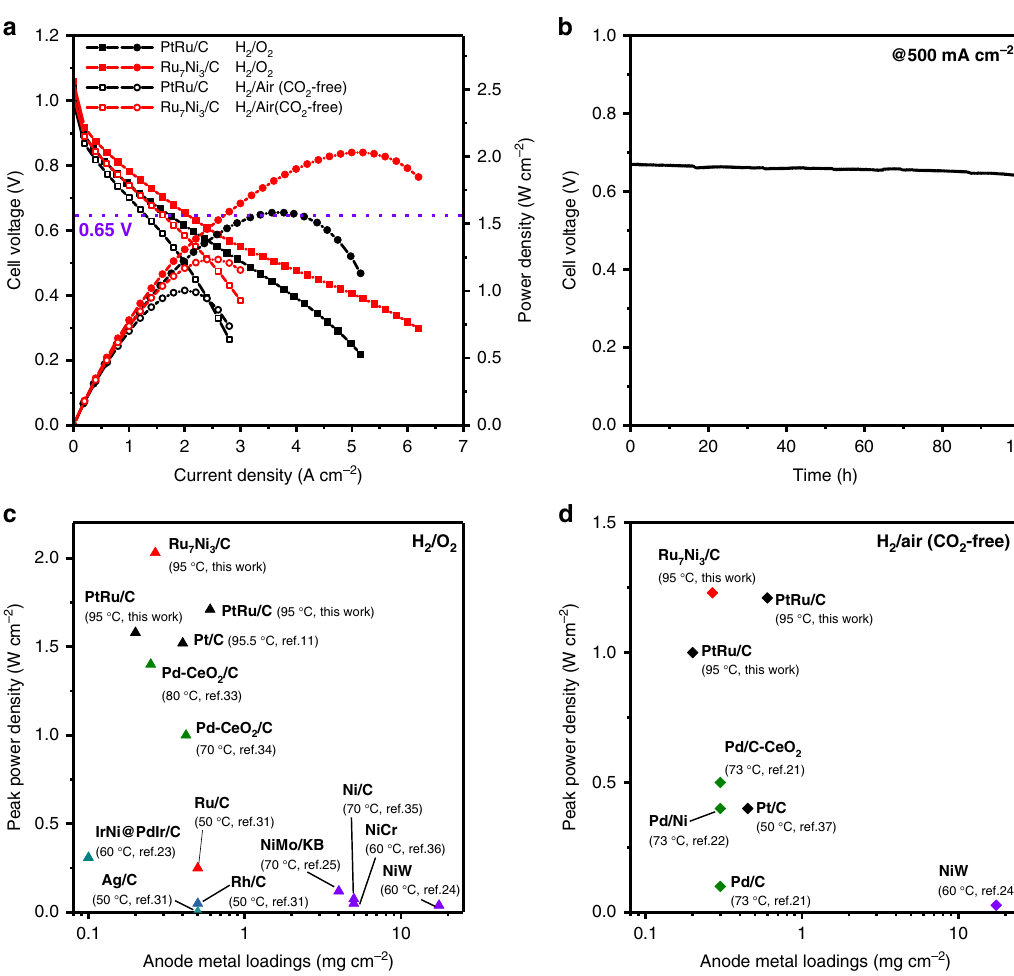
Fig. 3 Hydroxide exchange membrane fuel cells (HEMFCs) performance and durability. a Polarization and power density curves of H 2 /O 2 and H 2 /air (CO 2 -free) HEMFCs with Ru 7 Ni 3 /C (0.2 mg Ru cm − 2 ) or PtRu/C (0.2 mg PtRu cm − 2 ) in anode and Pt/C (0.4 mg Pt cm − 2 ) in cathode. Test conditions: cell temperature at 95 °C, anode humidi fi er temperature at 88 °C and cathode humidi fi er temperature at 97 °C, H 2 fl ow rate at 1.0 L min − 1 and O 2 /CO 2 -free air − 2 fl ow rate at 2.0 L min − 1 , backpressures were symmetric at 250 kPag. b H 2 /CO 2 -free air HEMFCs durability test at a constant current density of 0.5 A cm with Ru 7 Ni 3 /C (0.1 mg Ru cm − 2 ) in anode and Pt/C (0.4 mg Pt cm − 2 ) in cathode. Test conditions: cell temperature at 80 °C, anode humidi fi er temperature at 79 °C and cathode humidi fi er temperature at 80 °C, H 2 fl ow rate at 0.5 L min − 1 and CO 2 -free air fl ow rate at 0.5 L min − 1 , backpressures were symmetric at 150 kPag. c , d The summary of the reported H 2 /O 2 and H 2 /air (CO 2 -free) HEMFC performances using different anode catalysts measured in this paper and the Pt-free catalysts in the reported literature, respectively.